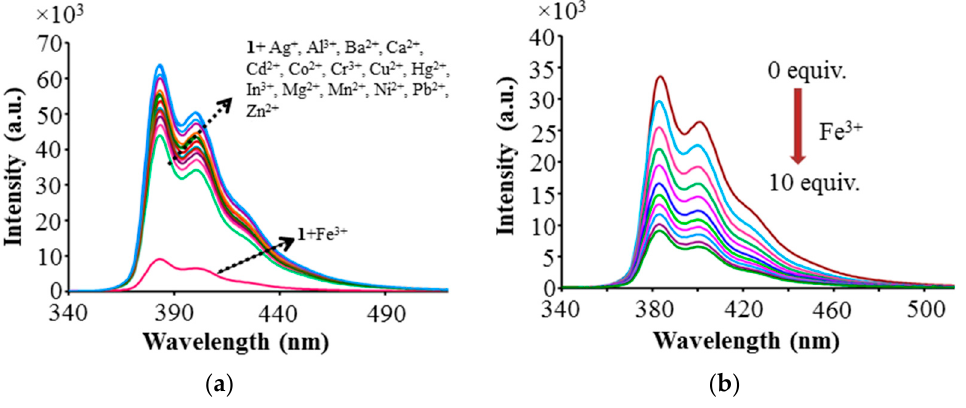
Figure 3. ( a ) Fluorescence spectra of receptor 1 (c = 1.0 × 10 − 5 M) upon the addition of various metal ions (10 equiv.); excitation wavelength: 280 nm. ( b ) Fe 3+ concentration-dependent changes in the fluorescence spectra of 1 (c = 1.0 × 10 − 5 M) upon the addition of Fe 3+ ions (0–10 equiv.); excitation wavelength: 280 nm.